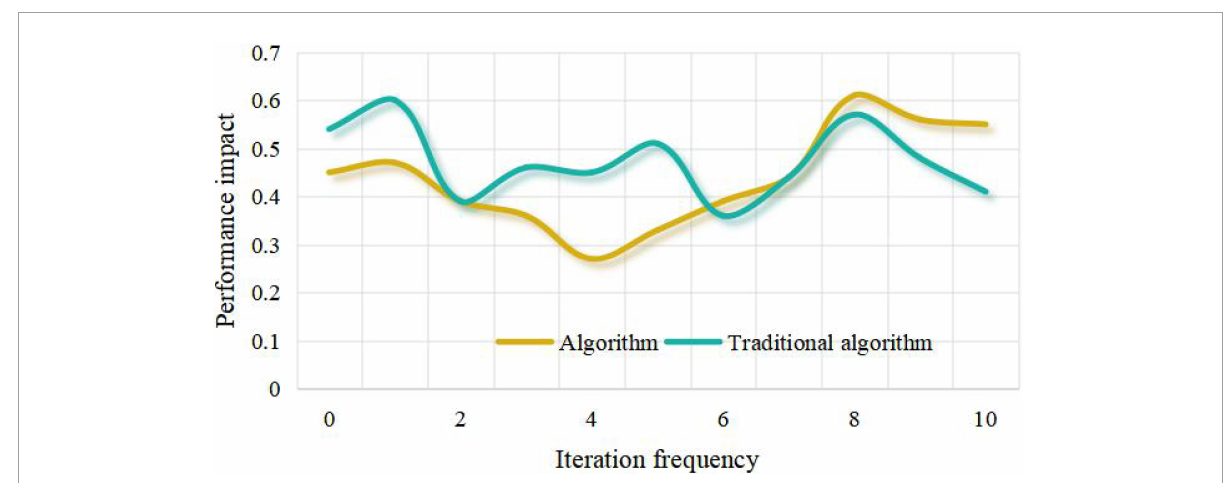
FIGURE6 Influence of iteration frequency on the performance of similarity learning algorithm without considering